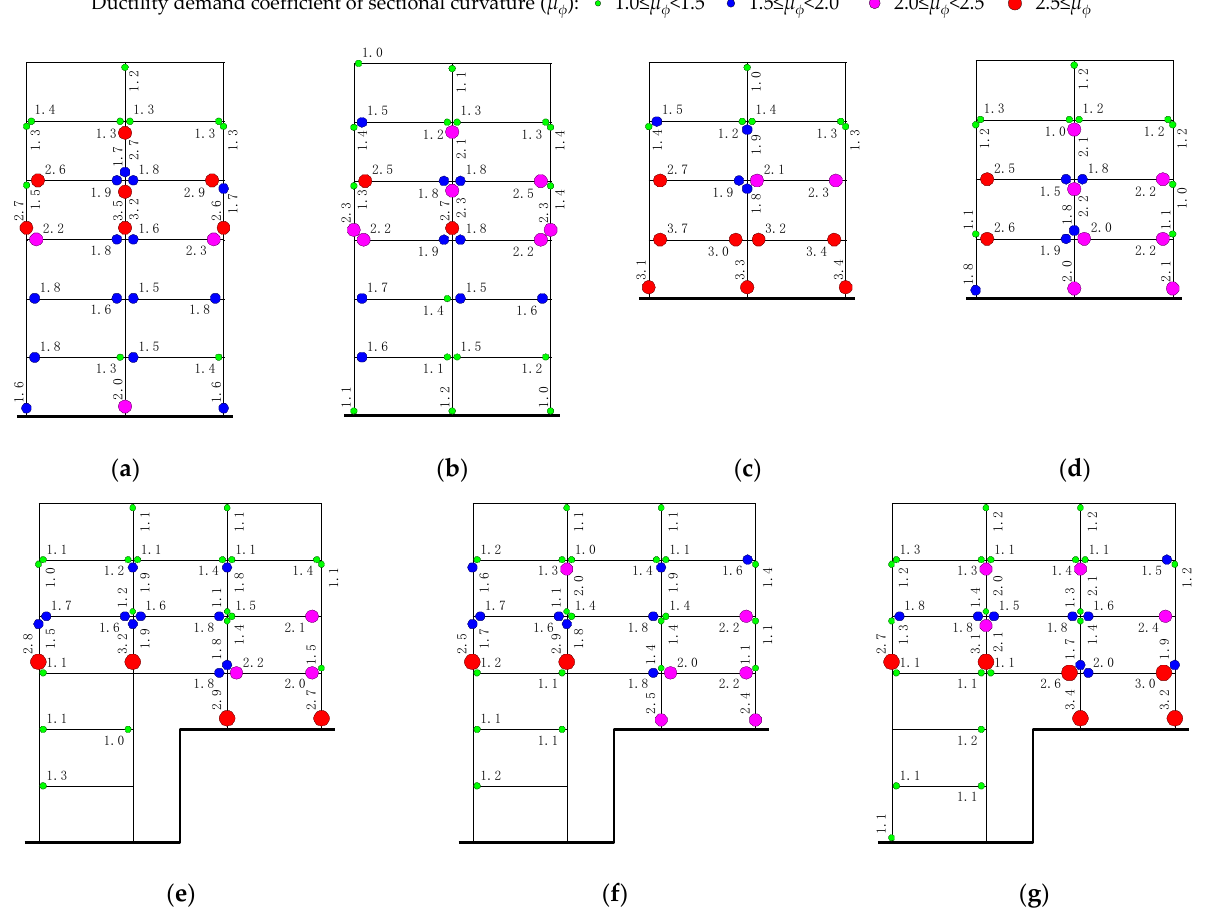
Figure 12. Plastic hinges of the structure under natural wave 2 with seismic intensity of 0.62 g: ( a ) Axis 1; ( b ) Axis 2; ( c ) Axis 3; ( d ) Axis 4; ( e ) Axis A; ( f ) Axis B; ( g ) Axis C. Due to the torsional effect, the damage of the border upper-embedding columns along the slope direction and the innermost upper-embedding columns across the slope direction is severer than other upper-embedding columns. The damages of the upper-embedding story and the adjacent upper story are unevenly distributed, and the heavily damaged columns are found in opposite positions. The torsional effect makes the lower-embedding column more prone to hinge across the slope